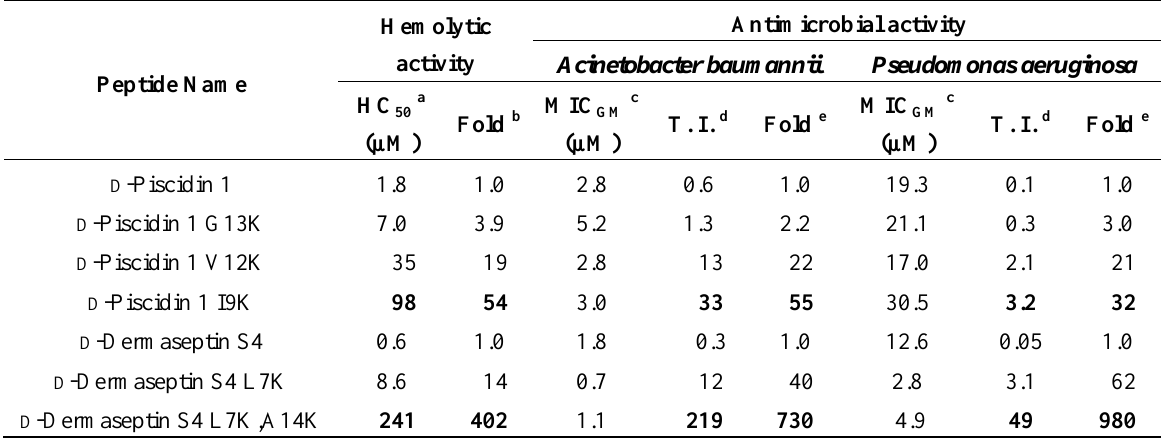
Table 4. Summary of biological activity of D -piscidin 1 and D -dermaseptin S4 analogs.